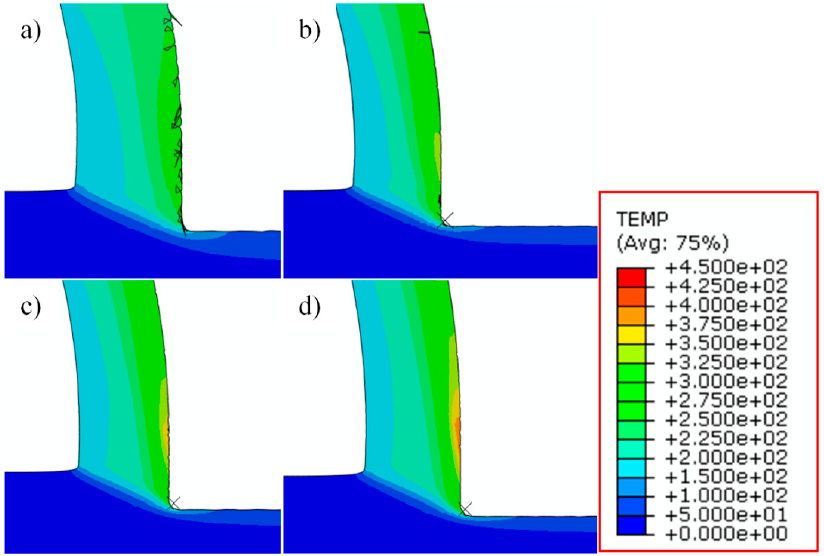
Figure 12. Temperature distributions inside chips at different cutting speeds, ( a ) 750 m/min, ( b ) 1500 m/min, ( c ) 2250 m/min and ( d ) 3000 m/min.